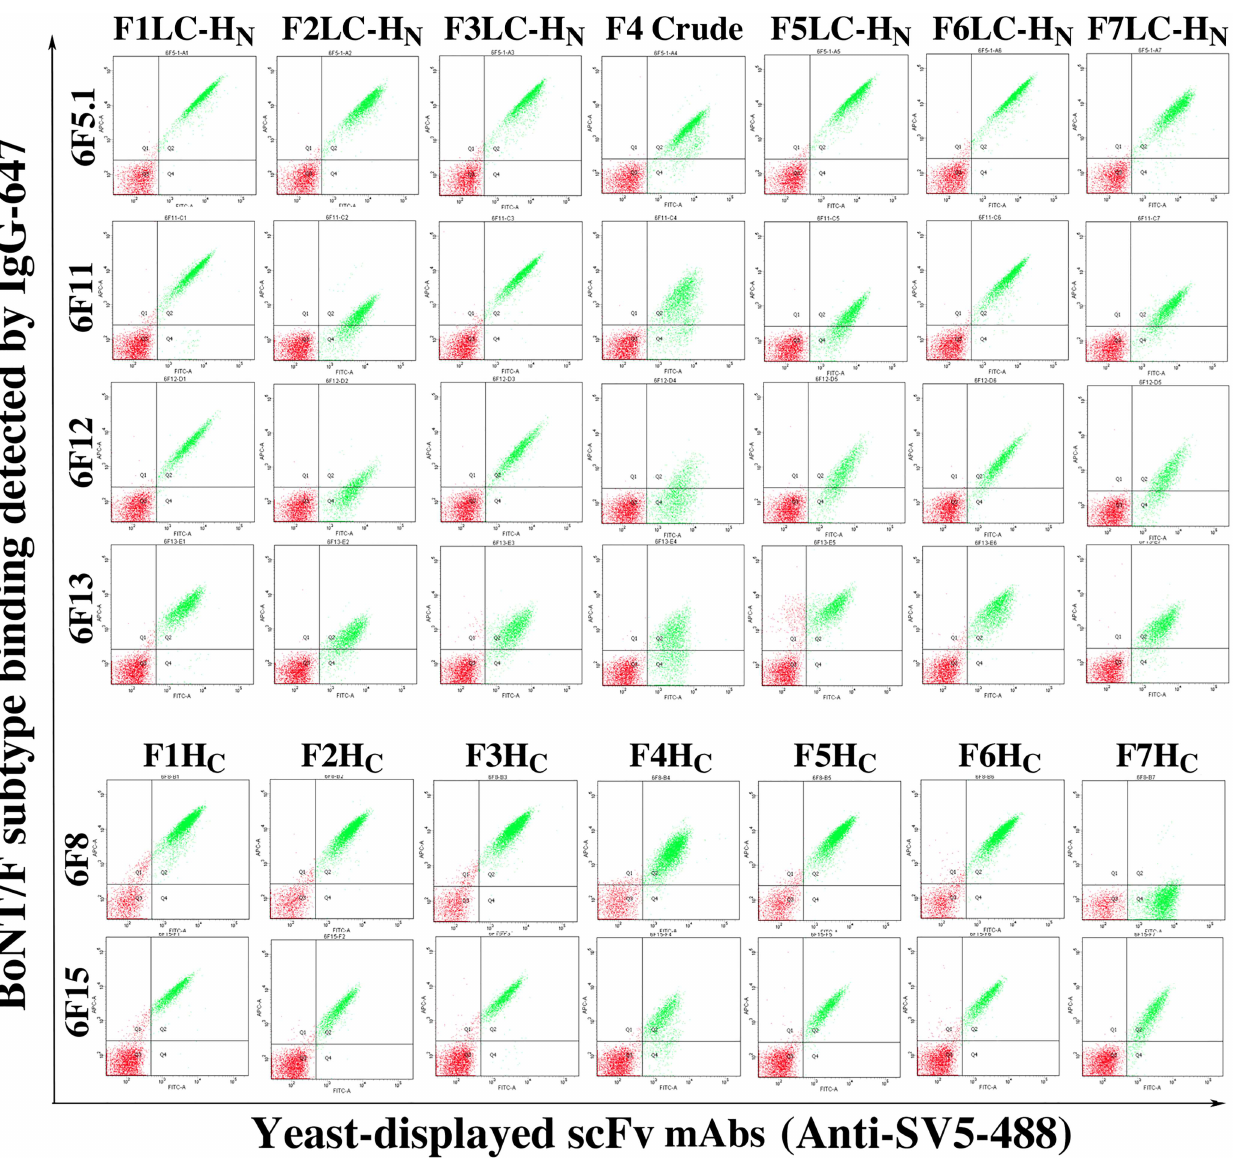
Fig 2. Cross reactivity of the affinity matured mAbs against BoNT/F subtypes. Yeast-displayed single chain Fv were incubatedwith BoNT/F LC-H N or H C fragments followedby an Alexa-647 labeledsecondaryIgG for bindingdetection. An Alexa-488labeledanti-SV5 IgG was used to detect scFv mAb expressionon the yeast surface. For 6F5.1, 6F11, 6F12 and 6F13, BoNT/F LC-HN fragments or BoNT/F4 crude toxin were used (the upper panel)and for 6F8 and 6F15, BoNT/F H C fragments were